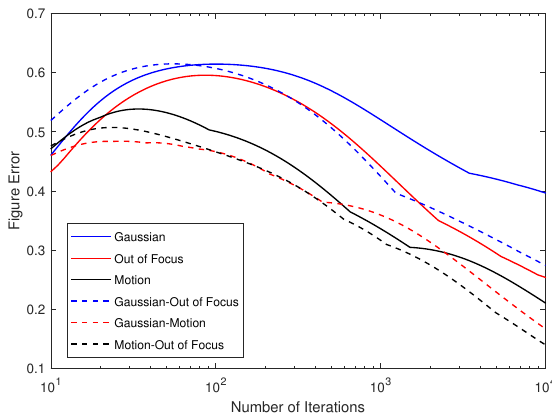
Figure 31. Figure error plots of the proposed algorithm in all cases of grey images.